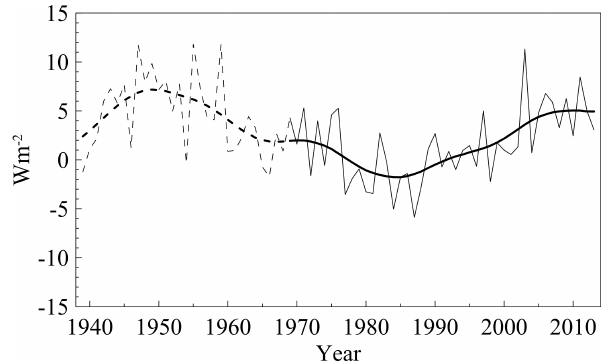
Figure 5. Composite of 56 European GEBA time series of an- nual surface downward shortwave radiation (thin line) from 1939 to 2013, plotted together with a 21-year Gaussian low-pass filter (thick line). The series are expressed as anomalies (Wm − 2 ) from the 1971–2000 mean. Dashed lines are used prior to 1961 due to the lower number of records for this initial period. Updated from Sanchez-Lorenzo et al. (2015) including data until December